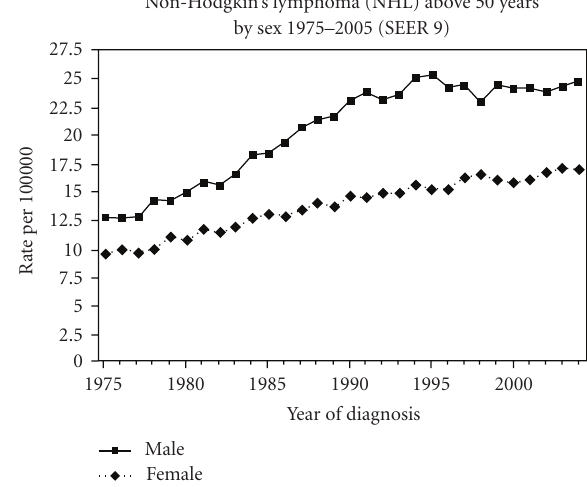
Figure 1: Incidence for all races of human NHL in individuals less than 50 years of age, adapted from the SEER webpage (http://www.seer.cancer.gov/). Rates are adjusted to the 2000 US Std. Population (19 age groups Census P25-1130).